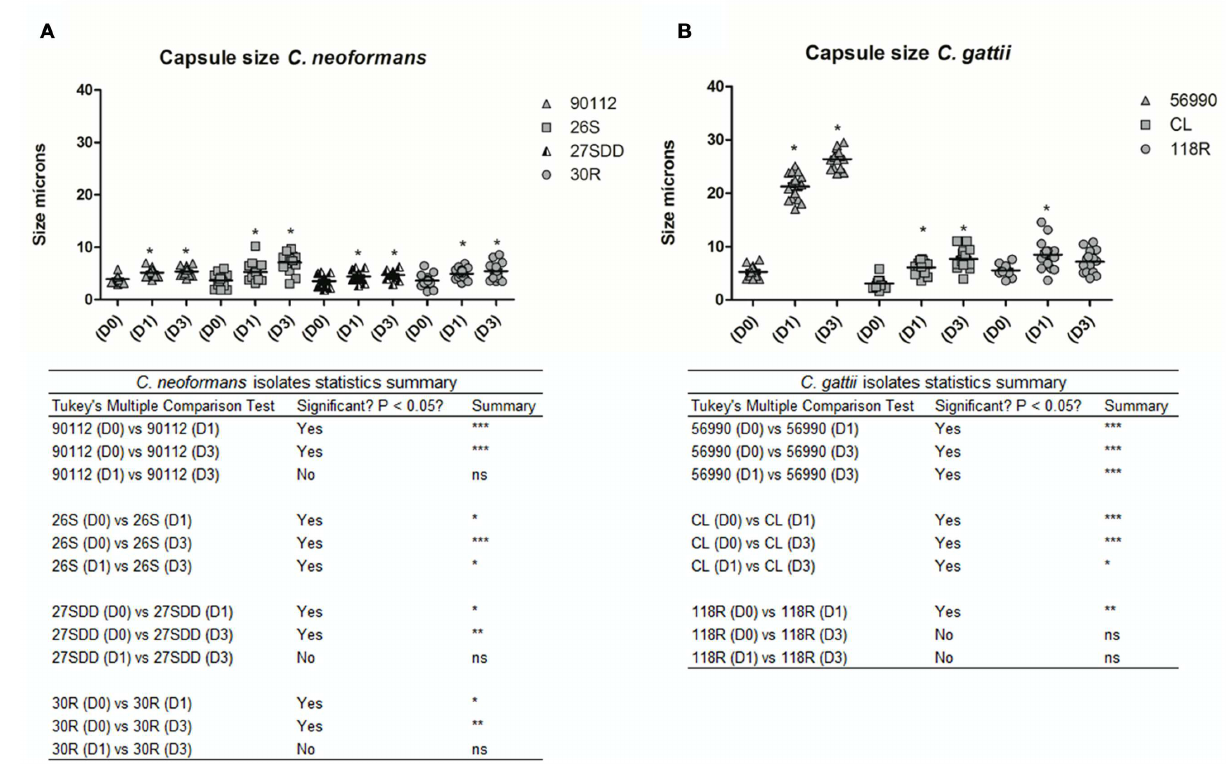
FIGURE 6 | Capsule size in microns of isolates of C. neoformans and C. gattii after infection in G. mellonella . The cells were recovered from G. mellonella at different times (D1 and D3) and controls were grown in Sabouraud (D0). (A) ATCC 90112 and isolates 26S, 30R, and 27SDD of C. neoformans ; (B) ATCC 56990 and isolates CL and 118R of C. gattii . ∗ p < 0.05; ∗∗ p < 0.01; ∗∗∗ p <